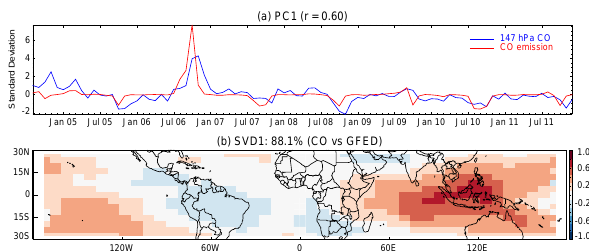
Fig. 3. SVD analysis results of 147hPa CO and CO emission for the period of August 2004–December 2011: (a) principle components (PCs) of 147hPa CO (blue) and CO emission (red) for the first SVD mode and (b) heterogeneous correlation map of 147hPa CO (i.e., correlation between 147 hPa CO and the PC of CO emission) for the first SVD mode.